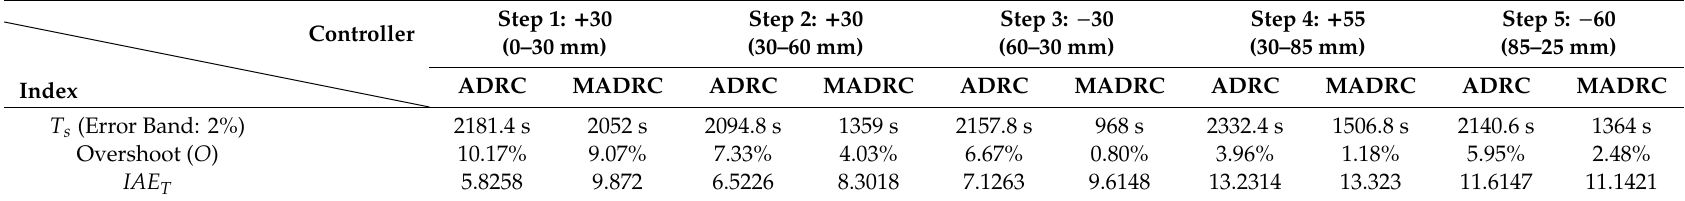
Table 1. Evaluation